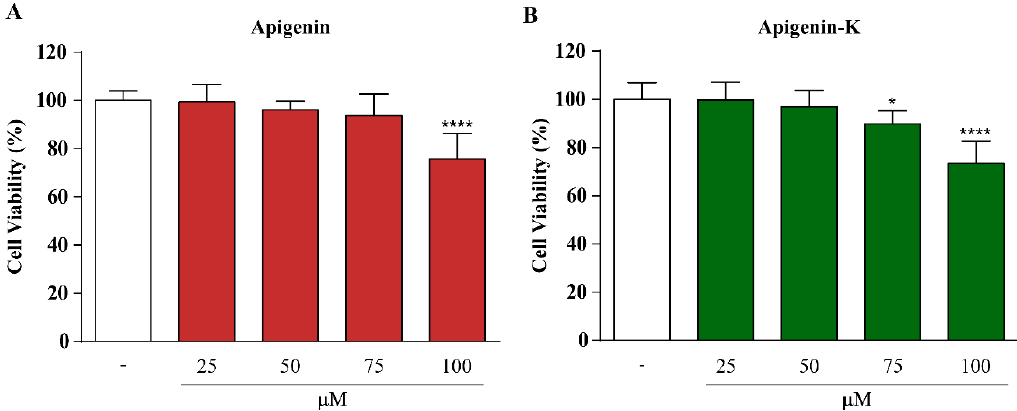
Figure 2. Cytotoxic effects of apigenin ( A ) and apigenin-K ( B ) treatment (25, 50, 75 or 100 µM) for 2 h in Caco-2 cells determined using the MTT assay. The data are expressed as the means of 6 replicates ± SDs. * p < 0.05 and **** p < 0.0001 indicate statistically significant differences compared with nontreated cells.